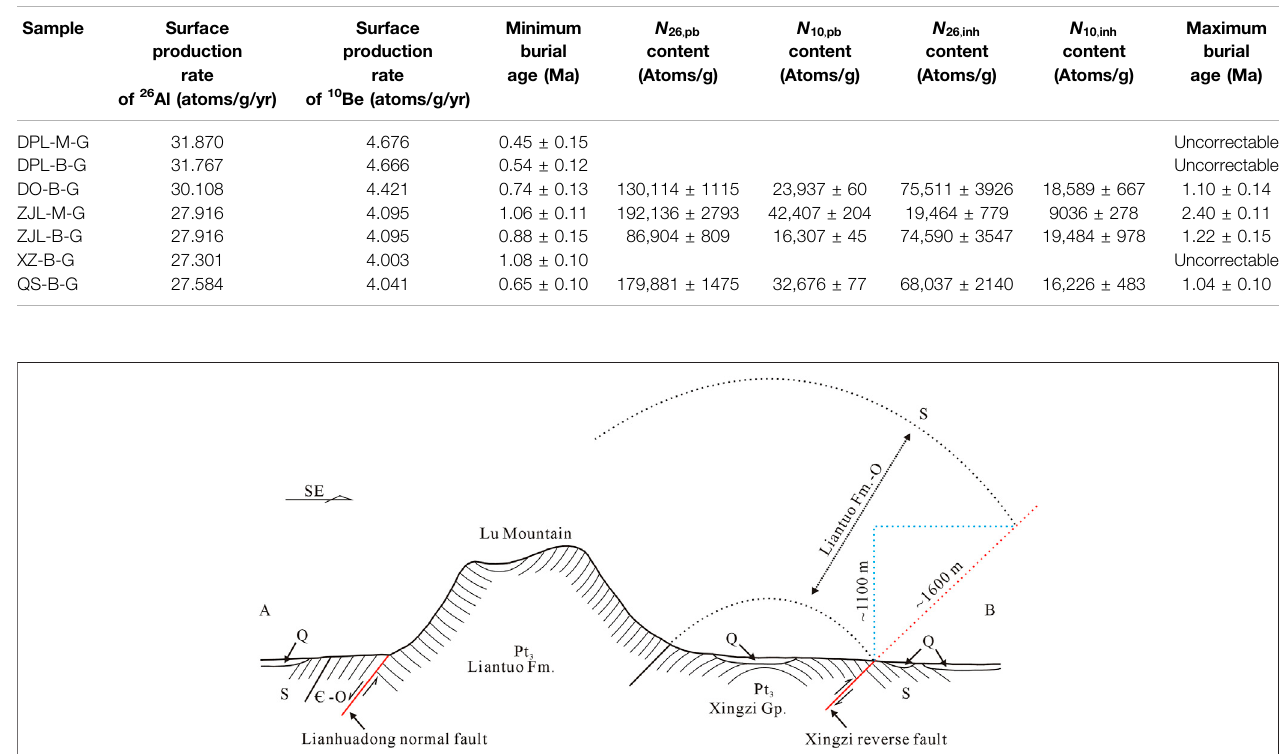
Frontiers in Earth Science |